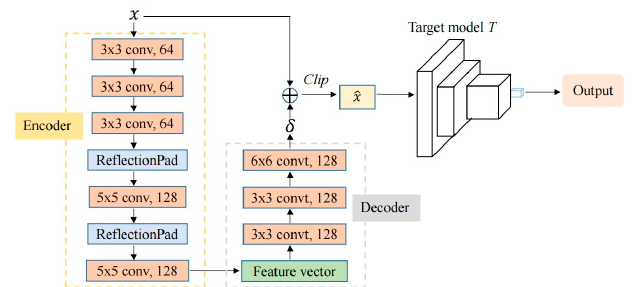
Figure 2. The attack procedure on MNIST dataset.